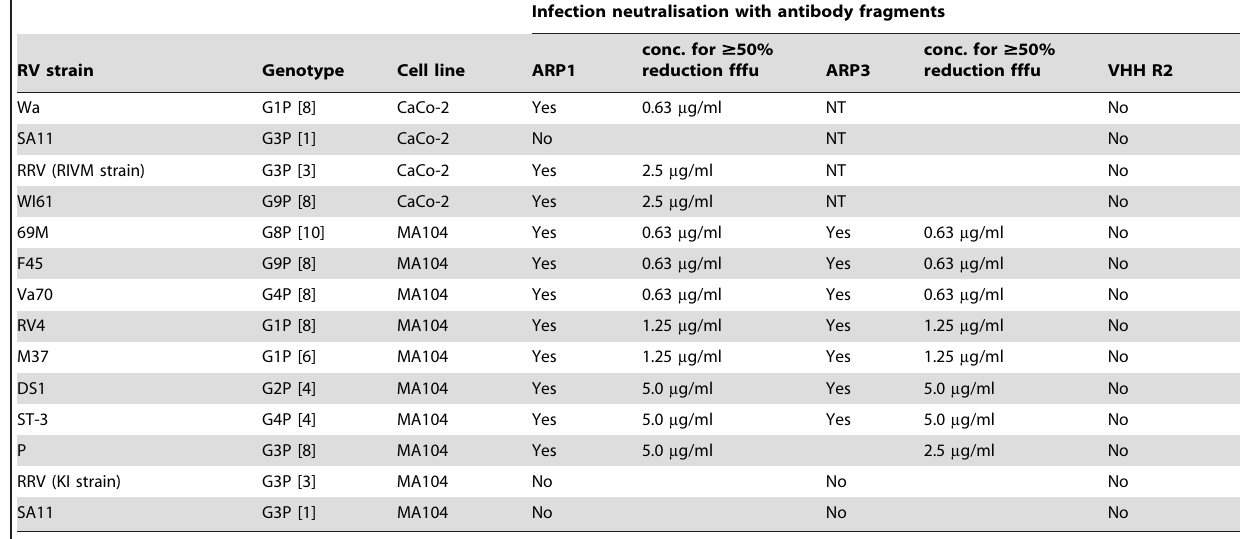
Table 1. Infection neutralisation of different rotavirus strains with rotavirus-specific antibody fragments ARP1 and/or